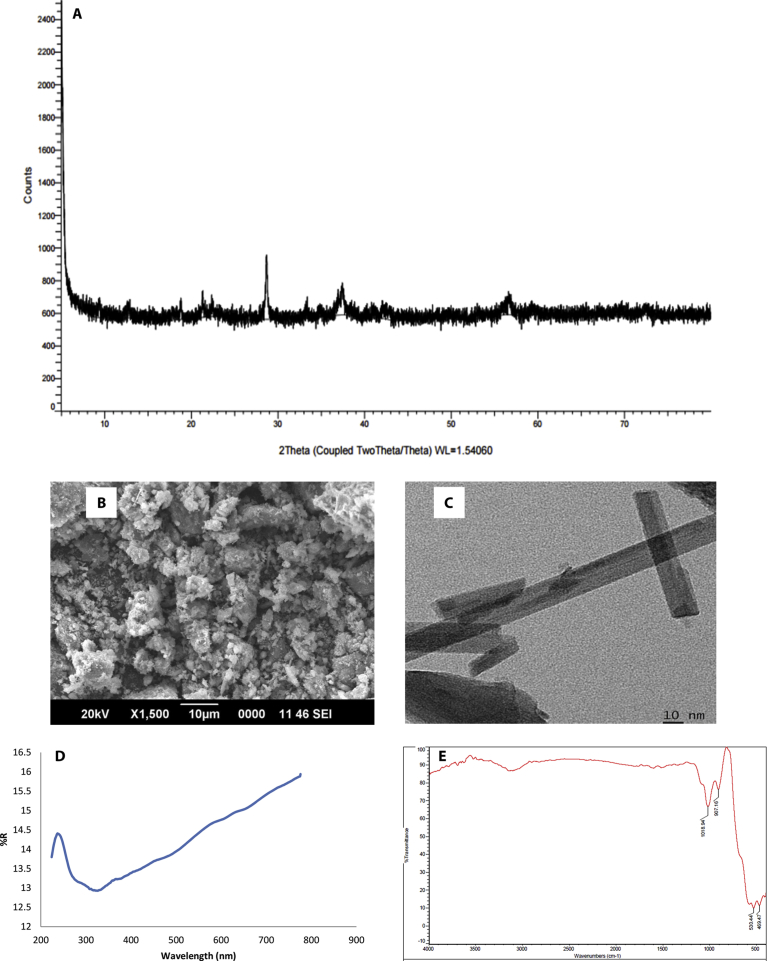
A: XRD of MnO2, B: SEM image and C: TEM image of MnO2, D: DRS of MnO2, E: FTIR spectrum of MnO2.